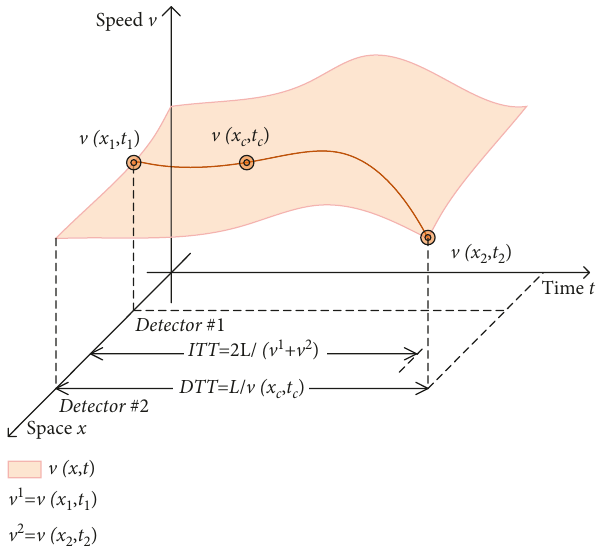
Figure 3: Relationship between ITT and